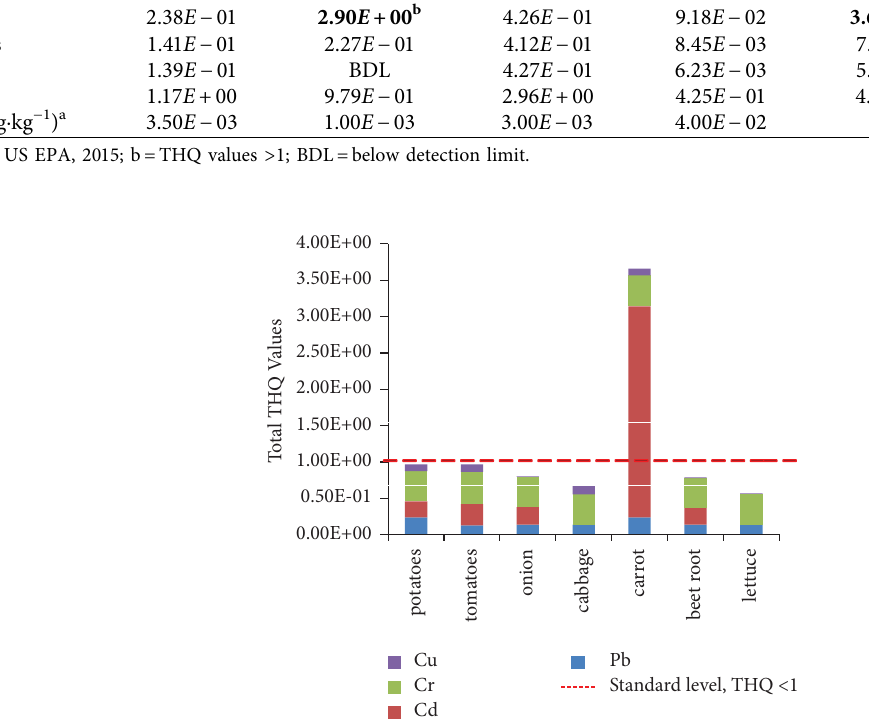
Figure 2: Te total THQ values for Pb, Cd, Cr, and Cu in vegetables of the study